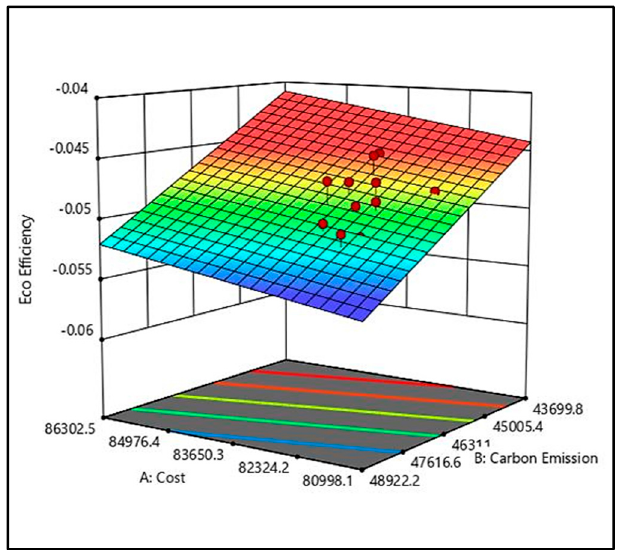
Figure 12. Response surface graph of blast furnace slag based concrete used for single story houses.